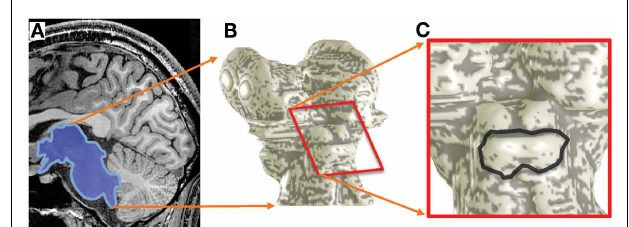
FIGURE 2 | Surface-model construction . (A) MRI volumes obtained with 0.7-mm voxels were segmented to delineate the boundaries of brainstem tissue (blue). (B) A smooth surface was constructed at the segmentation boundary; gray overlay shows curvature. (C) Enlargement showing IC boundaries